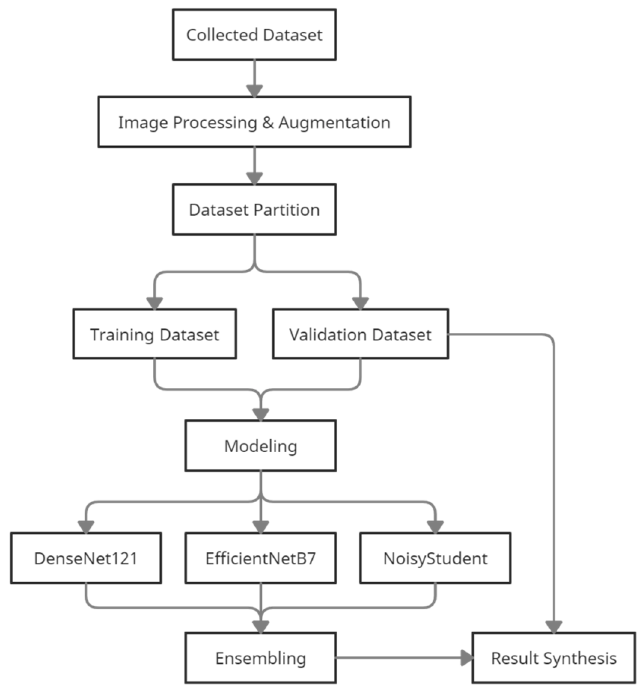
Figure 4. Workflow for the proposed methodology.